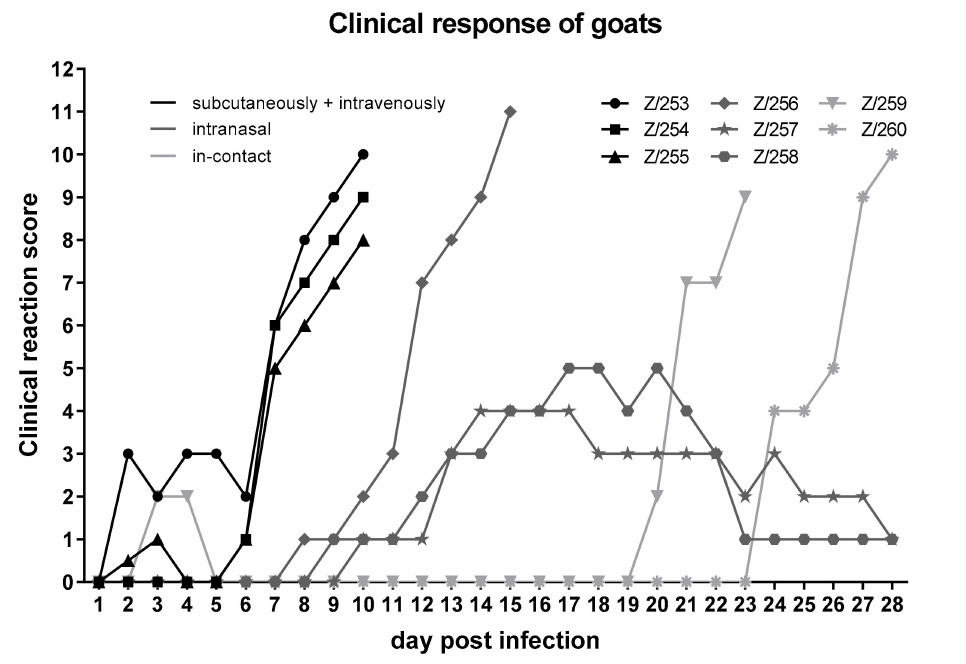
Figure 2. Clinical score of the goats inoculated with GTPV-“V / 103”. Three goats were inoculated both intravenously and subcutaneously or intranasal with GTPV-“V / 103“. Additionally, two in-contact goats were housed together with the inoculated